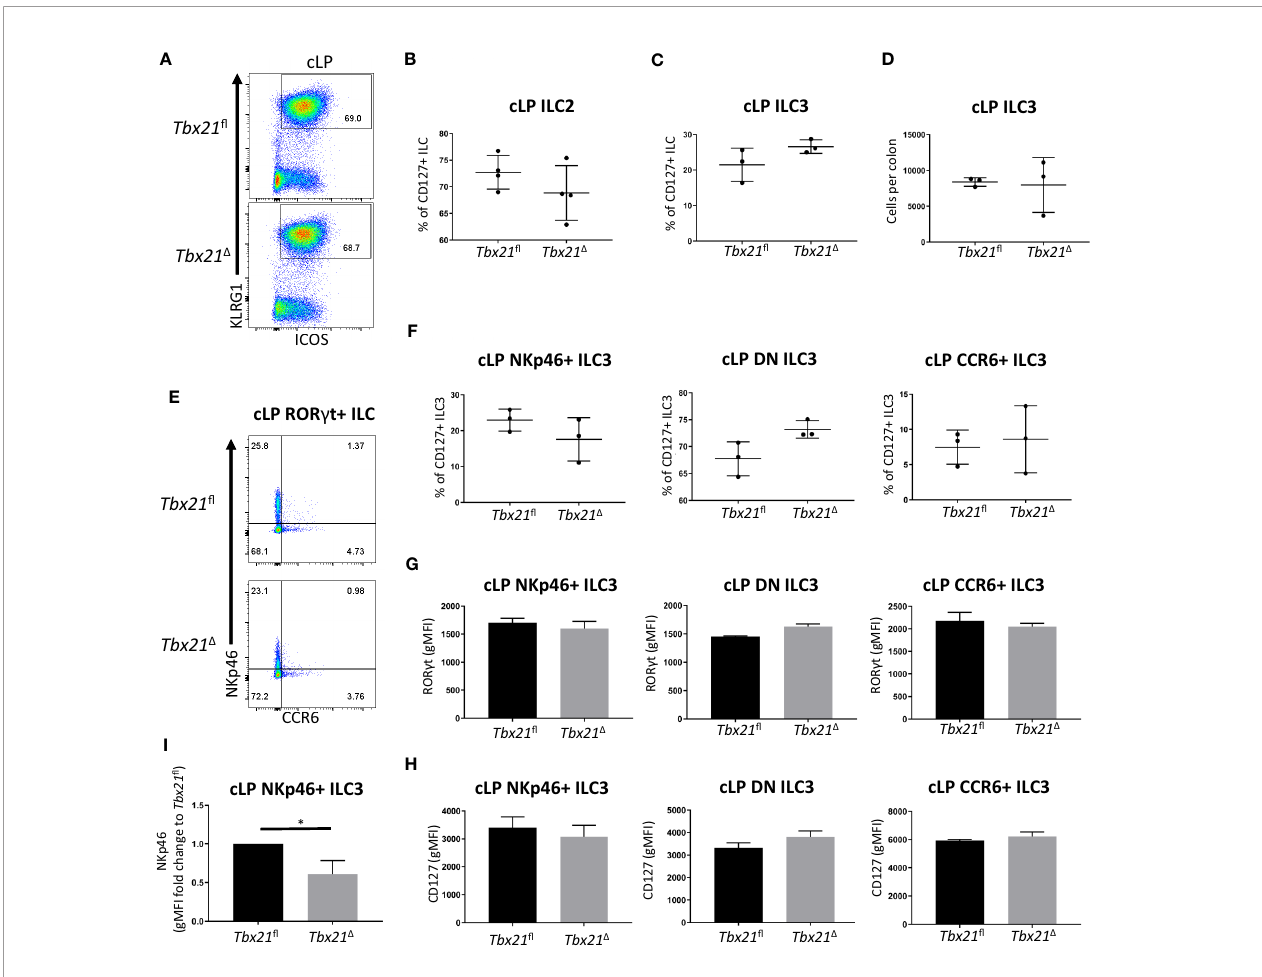
FIGURE 2 | Induced T-bet depletion in vivo does not alter cellularity of cLP ILC3 and ILC2. Tbx21 fl and Tbx21 D mice were treated with tamoxifen and fl ow cytometry analysis on intestinal ILC was performed 21 days after the fi rst injection of tamoxifen. (A) Flow cytometry analyses of cLP ILC2 from Tbx21 fl and Tbx21 D mice and (B) the percentage of cLP ILC2 from total CD127 + ILC are shown (n=4). (C) Frequency of ROR g t + ILC (ILC3) among CD127 + ILC and (D) ILC3 cellularity per colon are demonstrated. (E) cLP NKp46 + , CCR6 + and NKp46 - CCR6 - double negative (DN) ILC3 were analysed as live CD45 + Lin - CD127 + ROR g t + leukocytes. (F) Percentage of NKp46 + , DN and CCR6 + ILC3 among ILC3 in Tbx21 fl and Tbx21 D mice are outlined (n=3). (G) ROR g t and (H) CD127 expression geometric median of fl uorescence intensity (gMFI) in NKp46 + , NKp46 - CCR6 - DN and CCR6 + ILC3 from Tbx21 fl and Tbx21 D mice are illustrated (n=3). (I) gMFI of NKp46 expression fold change expression in in cLP NKp46 + ILC3 from Tbx21 fl and Tbx21 D mice are shown (n=3). *p <